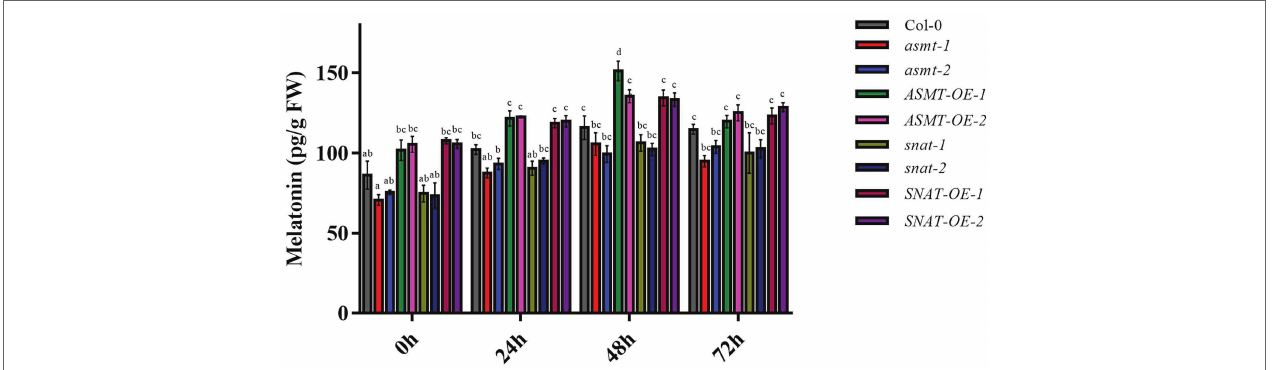
FIGURE 2 | Melatonin content following B. cinerea treatment. The content of melatonin in 4-week old wild-type (Col-0), ASMT -overexpressed ( ASMT-OE-1 , ASMT- OE-2 ) plants, SNAT -overexpressed ( SNAT-OE-1 , SNAT-OE-2 ) plants, snat silencing lines ( snat-1 , snat-2 ), and asmt silencing lines ( asmt-1 , asmt-2 ) were measured at different time points (0, 24, 48, and 72 h) after inoculation with B. cinerea . The data (mean ± SD) were calculated using three replicate assays, with the SEs indicated by the vertical bars. Different lowercase letters indicate statistically significant differences ( p < 0.05). FW, fresh weight.